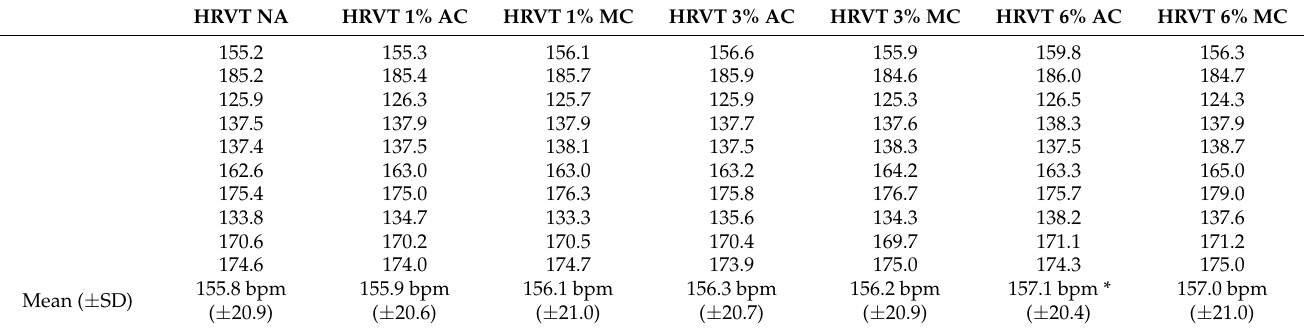
Table 2. Comparison of ECG derived heart rate at HRVT for 10 participants with no baseline artefact (NA), across each artefact condition and correction method. Mean ( ± standard deviation, SD) in last row. * denotes p ≤ 0.05 on t testing HRVT NA vs. HRVT for each artefact condition and correction method.